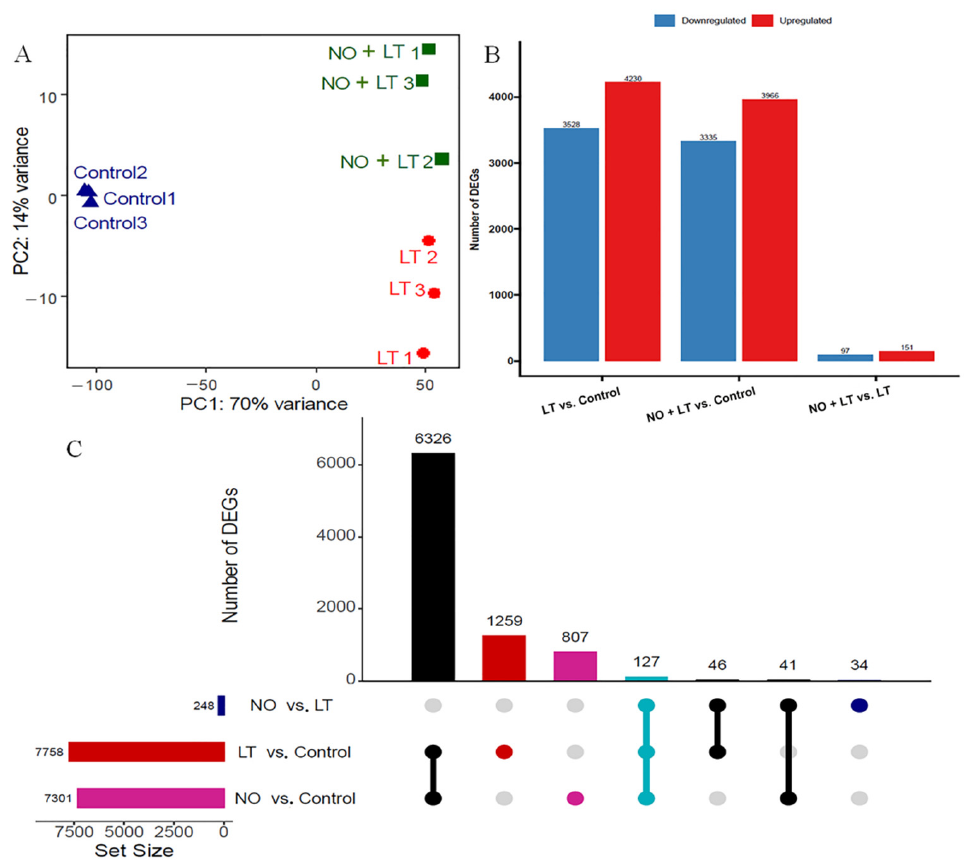
Figure 2. The differentially expressed genes (DEGs) in cucumber seedlings as influenced by nitric oxide (NO) pretreatment under low temperature (LT) stress. ( A ) Principal Component Analysis (PCA) of log 2 -transformed normalized read counts of each RNA-seq dataset of Control, LT, and NO + LT; ( B ) number of DEGs in LT vs. Control, NO + LT vs. Control and NO + LT vs. LT; ( C ) UpSet diagram for the DEGs obtained from the comparison of the three groups, the figures showing the sizes of DEG sets (left) and the combination matrix at the bottom shows the intersections between the sets and the bar above it encodes the size of the